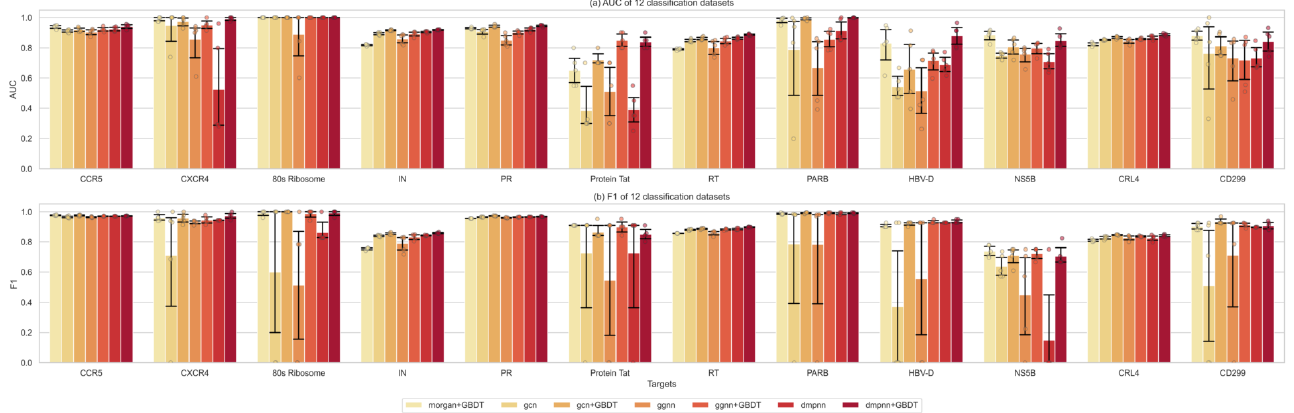
Figure 5. The performance comparison of different prediction models: morgan + GBDT, GCN, GCN + GBDT, GGNN, GGNN + GBDT, DMPNN, and DMPNN + GBDT. ( a ): the AUC values. ( b ): F1 metrics.